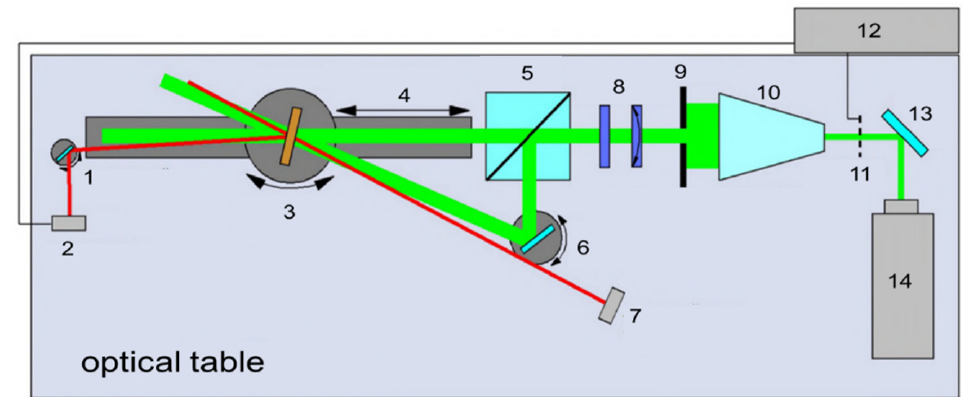
Figure A1. Scheme of the optical setup used for recording holographic gratings and monitoring the diffraction efficiency: 1—mirror mounted on a rotatable table, 2—power meter, 3—rotatable table with a specimen, 4—linear stage, 5—cubic beam splitter, 6—another mirror mounted on a rotatable table, 7—635 nm diode laser, 8—polarizing attenuator, 9—diaphragm, 10—telescopic beam